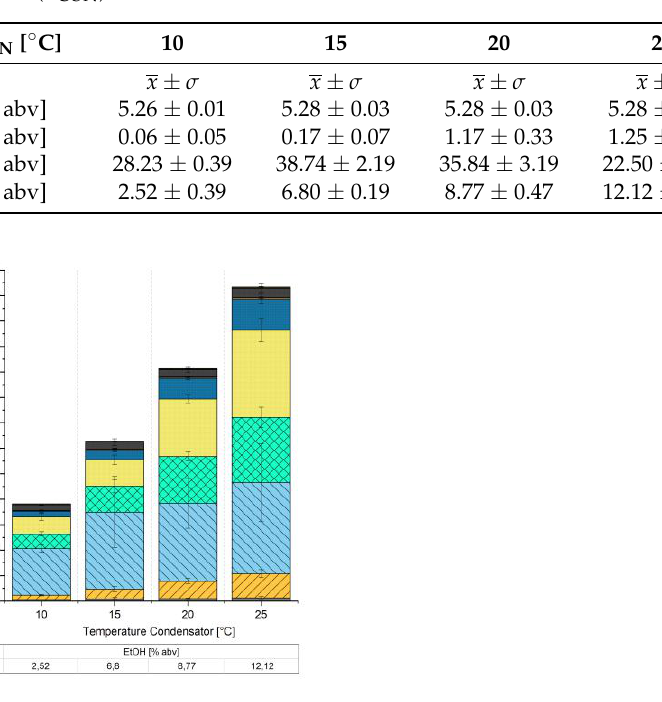
Table 1. Ethanol concentration (𝑥̅ ± 𝜎) in the original product (beer OB) and in the products ob- tained after the thermal dealcoholisation process: non-alcoholic beer (NAB), condensate (CON) and the fluid of the aroma recovery ‘aromawater’ (AW). The process was performed at different values for the condenser temperature (T CON ).